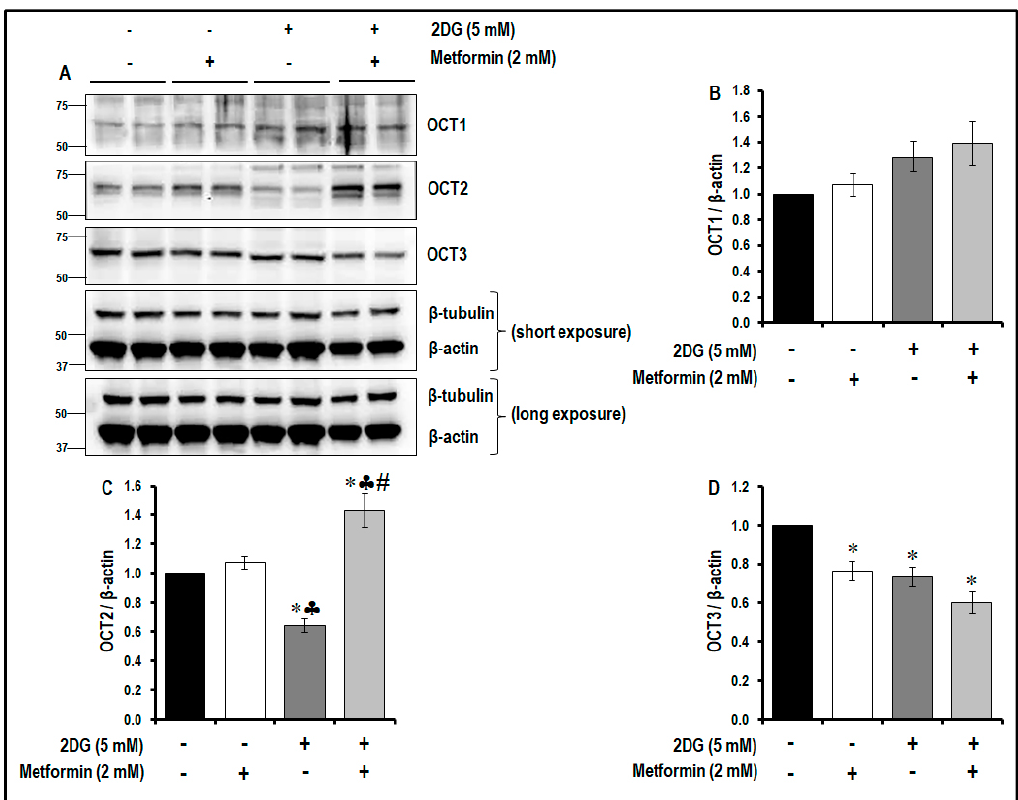
Figure 10. The levels of organic cation transporters-1, 2 and 3 (OCT1, OCT2 and OCT3) in metformin-treated normal glucose- and 2DG-exposed MMECs (48 h): Representative Western blots ( A ) show the levels of OCT1, OCT2 and OCT3 metformin (2 mM)-treated normal glucose- and 2DG (5 mM)-exposed MMECs. Non-treated cells and cells treated with metformin (2 mM) alone were used as suitable controls. Bar graphs represent the ratio of (normalized against β -actin loading controls) OCT1 / β -actin ( B ), OCT2 / β -actin (C) and OCT3 / β -actin ( D ) in the cells treated with 2DG (5 mM) with or without metformin (2 mM), after 48 h in culture. * p < 0.05 indicates significance when compared to non-treated controls, ♣ p < 0.05 indicates significance when compared to control + 2 mM metformin-treated cells and # p < 0.05 indicates significance when compared to 2DG (5 mM)-treated cells.